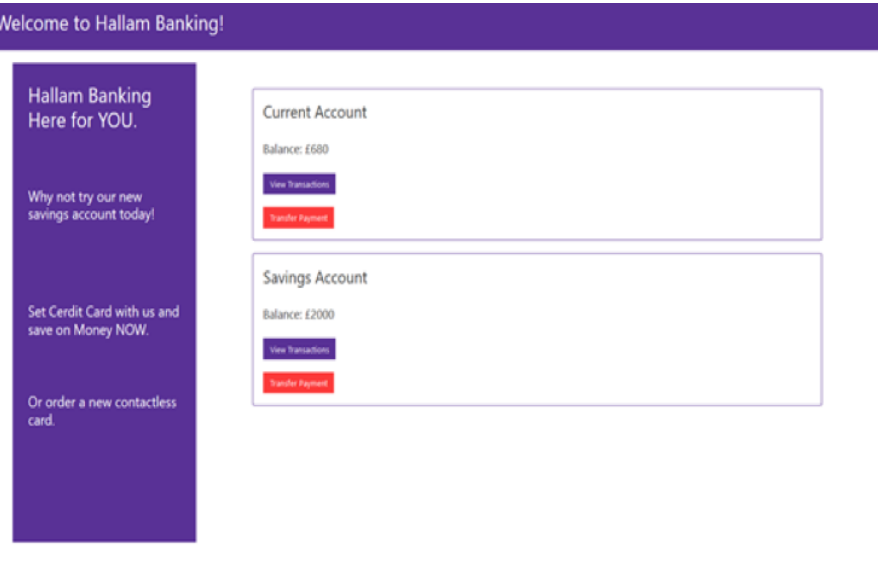
Figure 3. A screenshot of the main page of our flat